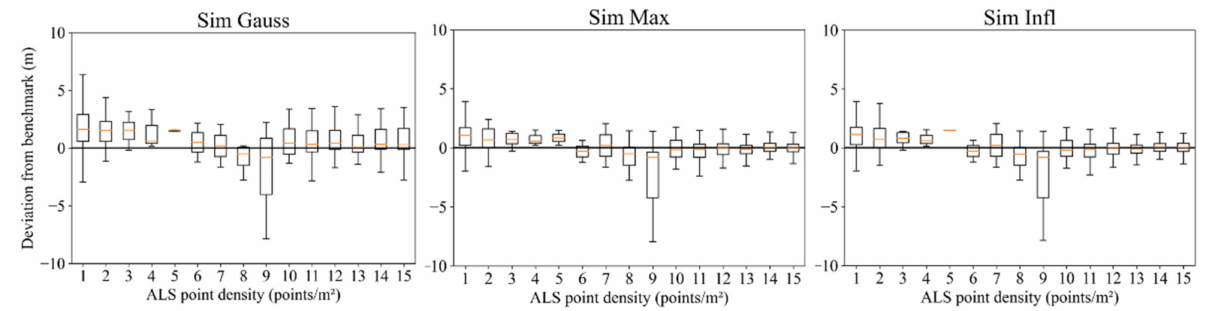
Figure 2. Deviation from true RH95 for the simulator’s Gaussian algorithm ( left ), Maximum al- gorithm ( centre ), and Inflection algorithm ( right ). Only observations with a terrain slope